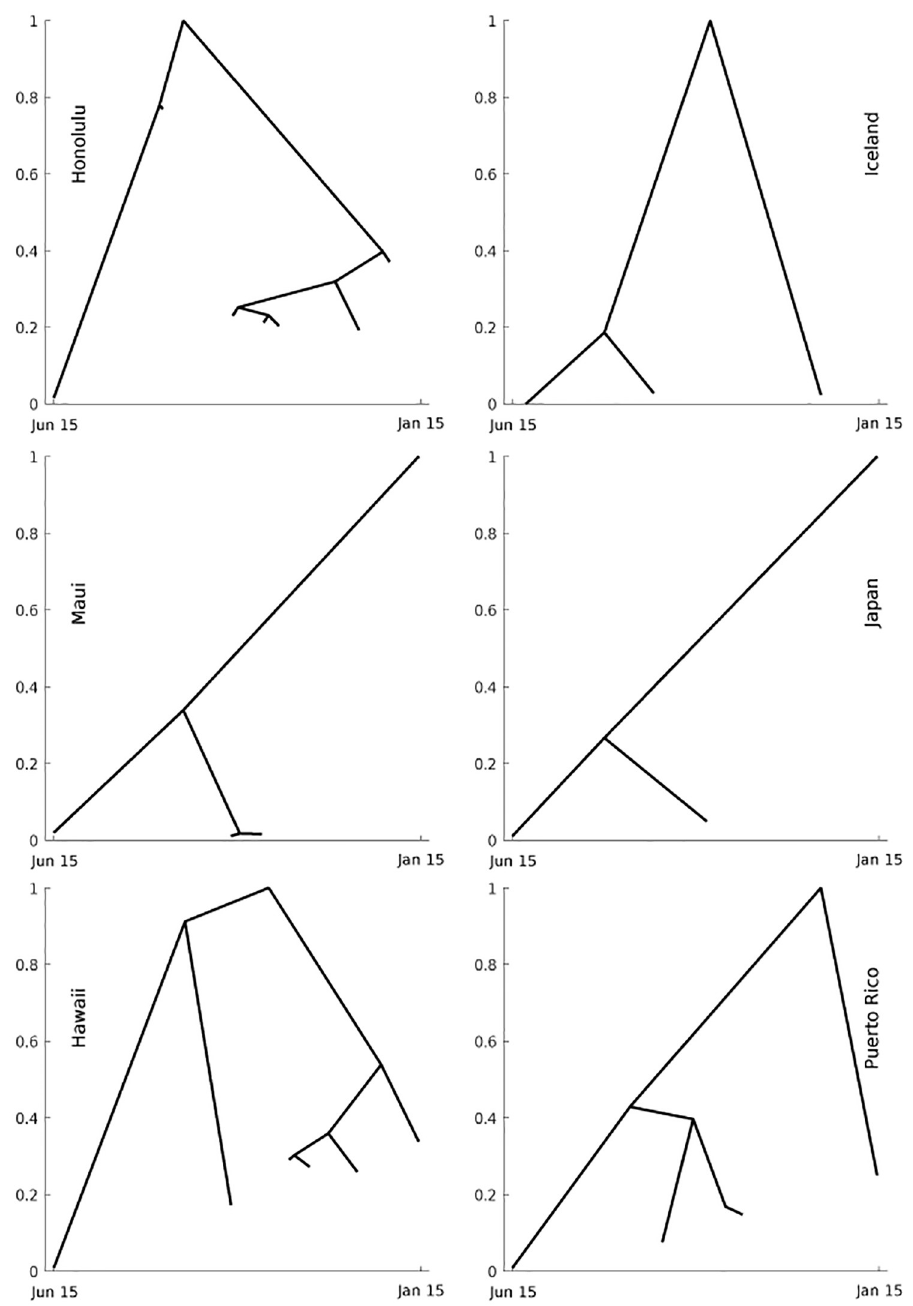
Fig 10. Merged trees. Merge trees elucidate the qualitative structure of the daily case numbers over